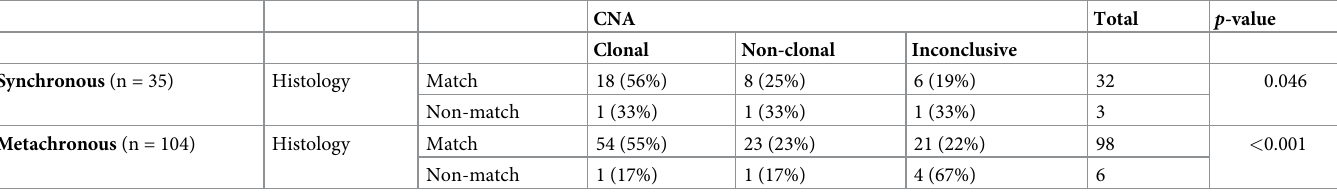
Table 4. Histology versus CNA-results for the subgroups of synchronous and metachronous tumor pairs. CNA Total p -value Clonal Non-clonal Inconclusive Synchronous (n = 35) Histology Match 18